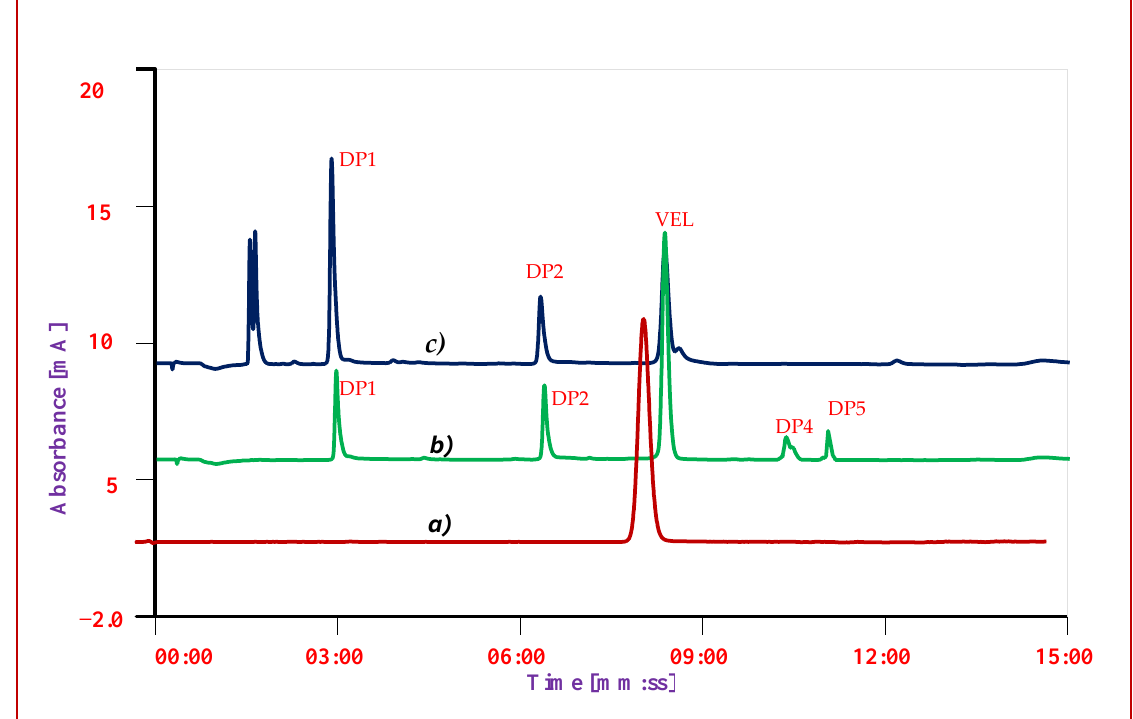
Figure 5. Chromatogram of VEL-CSD ( a ) Reference standard of VEL ( b ) Oxidative stress condition ( c ) Photolytic stressed studies.